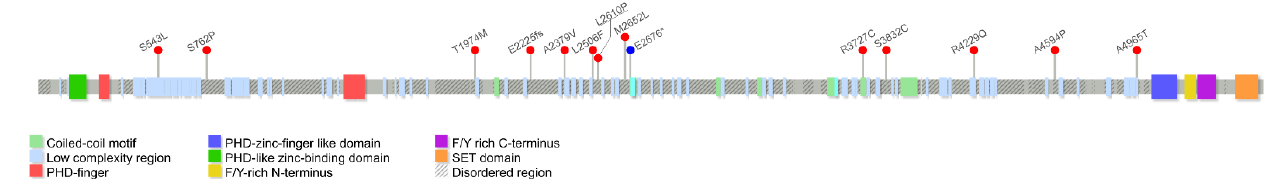
Figure 4. Distribution of the KMT2D mutations detected in this study, along the gene.